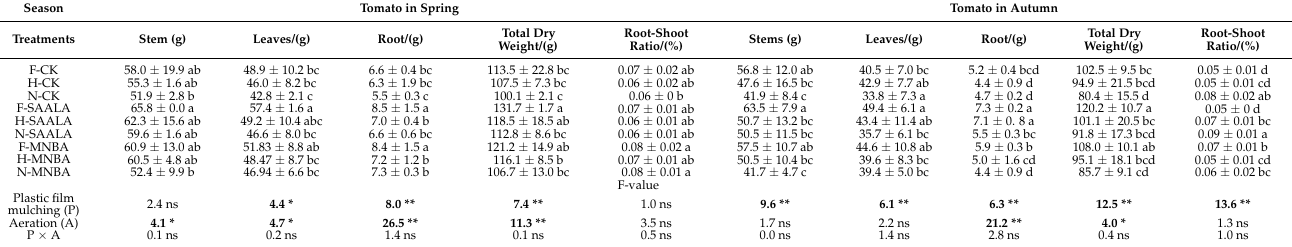
Table 2. Effects of different aeration treatments on the stem, leaf and root dry weight and the root–shoot ratio of a single tomato for spring and autumn tomatoes 120 and 160 days after